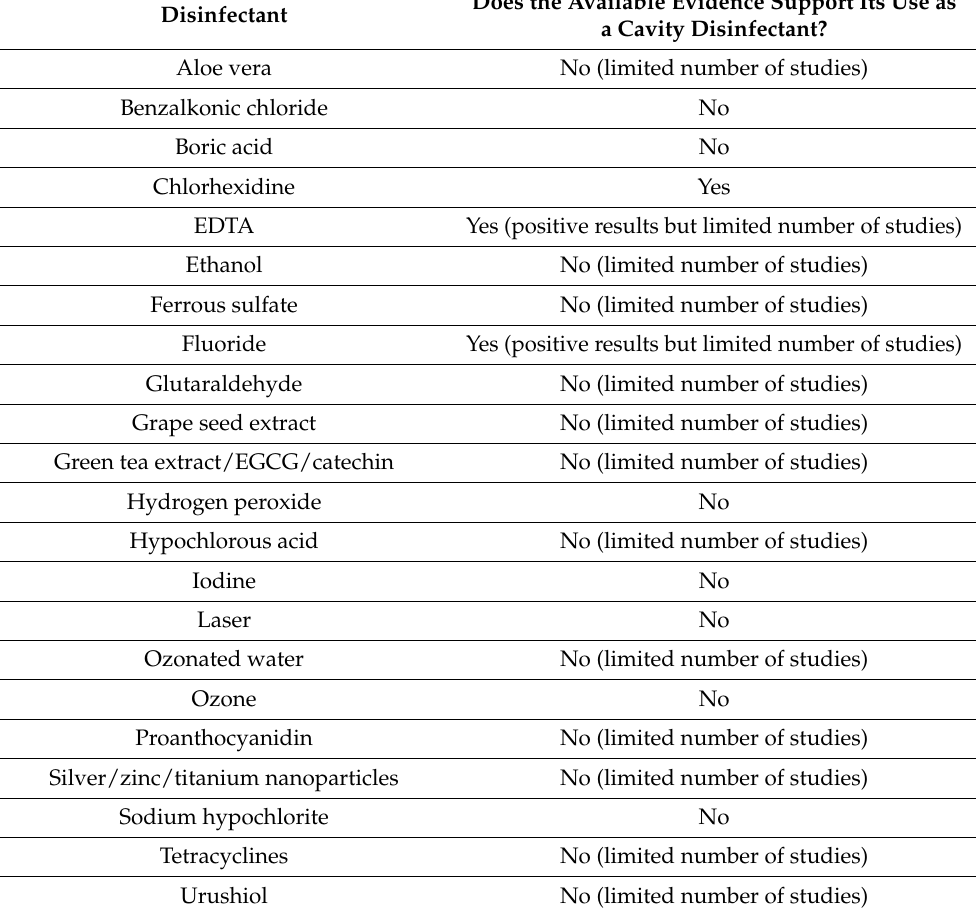
Table 2. Summary table of the available evidence on the use of cavity disinfectants. Does the Available Evidence Support Its Use as Disinfectant a Cavity